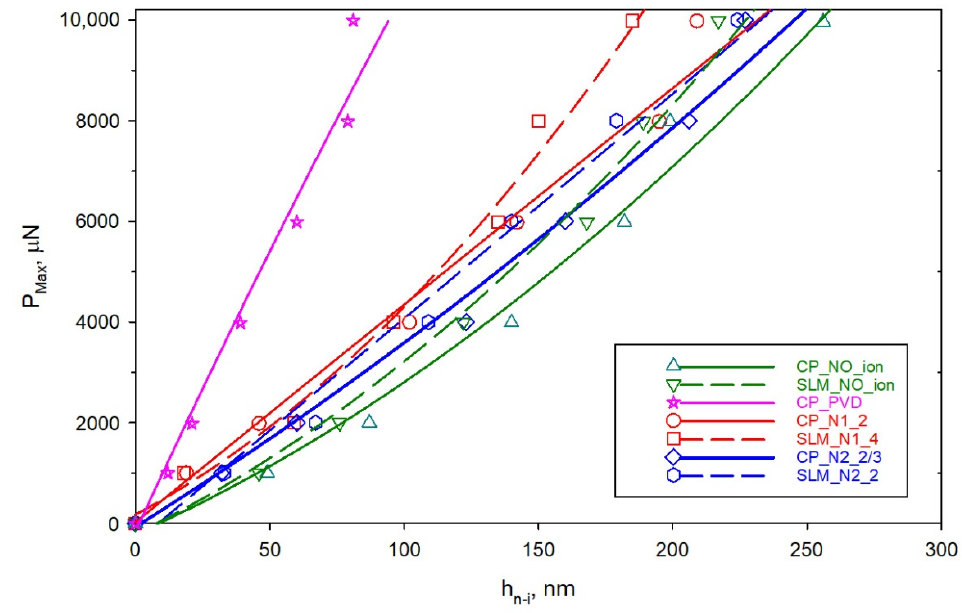
Figure 8. P Max vs. h n-i from nanoindentation measurements for various samples.